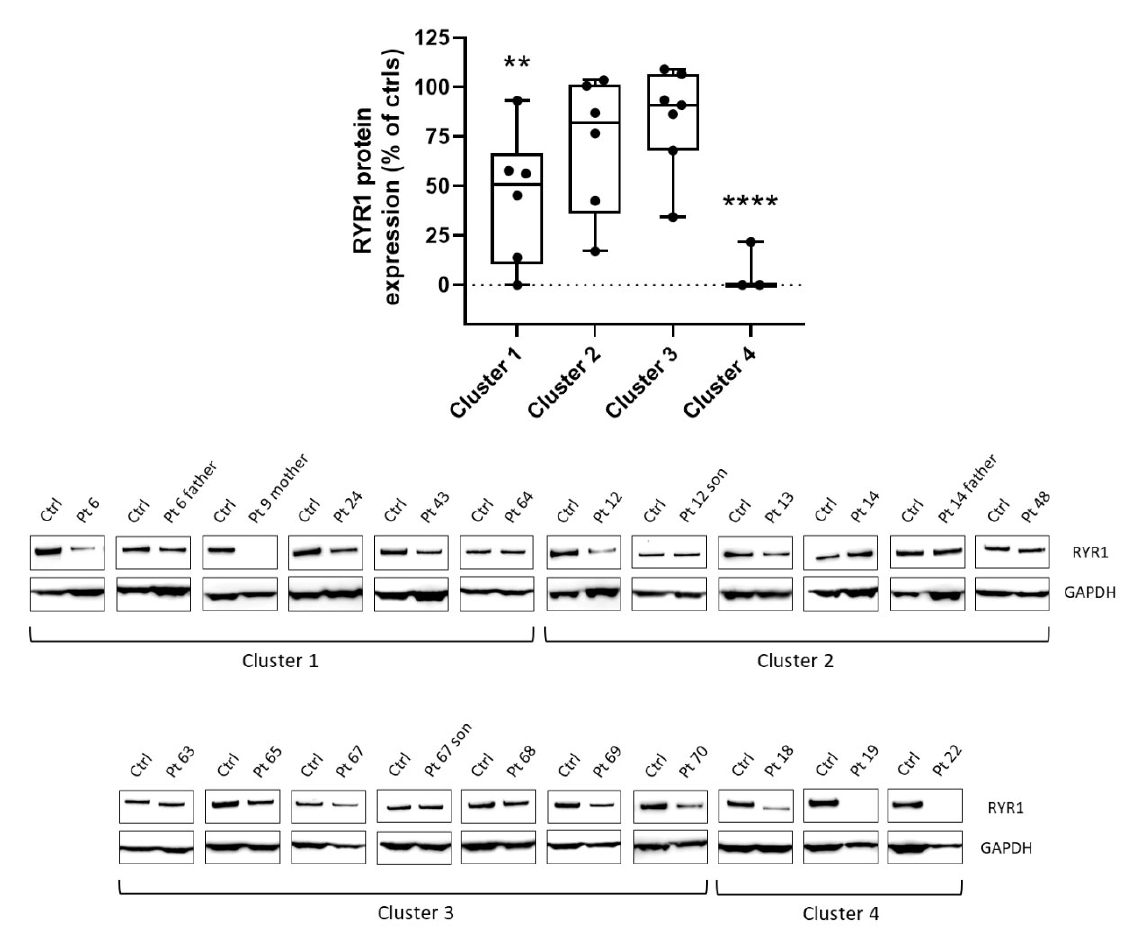
Figure 2. Dots-box plot (top) and representative Western Blot (bottom) show the levels of RYR1 protein in different clusters (expressed as % of controls) and protein detection, respectively. RYR1 protein levels of each cluster were compared to controls (whose levels were set equal to 100%). ** = p < 0.05; **** = p < 0.0001.